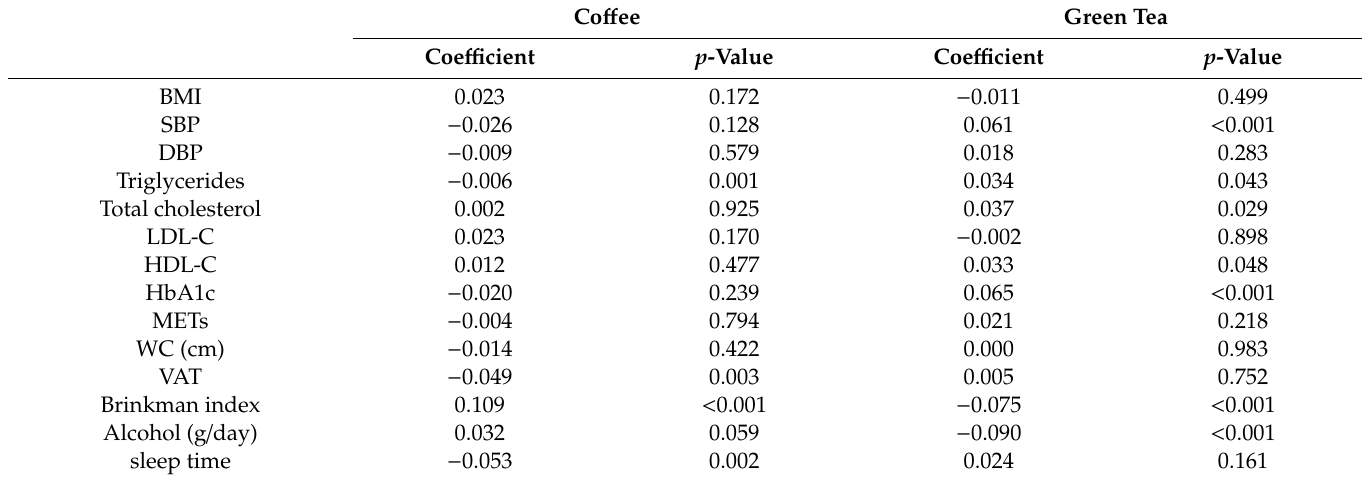
Table 2. Correlations between the consumption of co ff ee and green tea and each